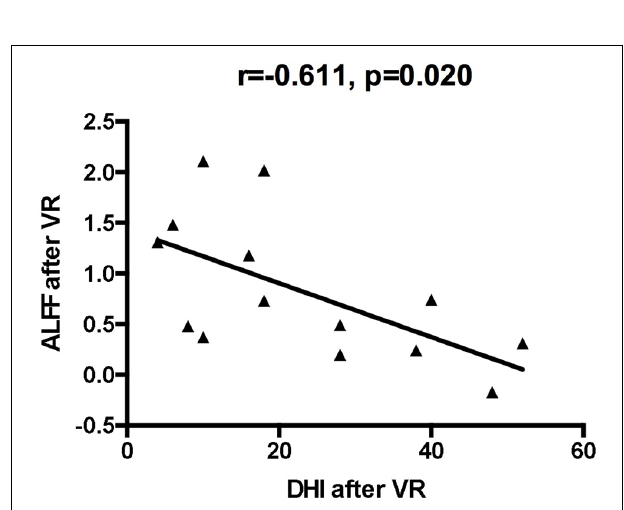
FIGURE 2 | The correlation of ALFF values of the left cerebellum posterior lobe with dizziness handicap inventory (DHI) values after